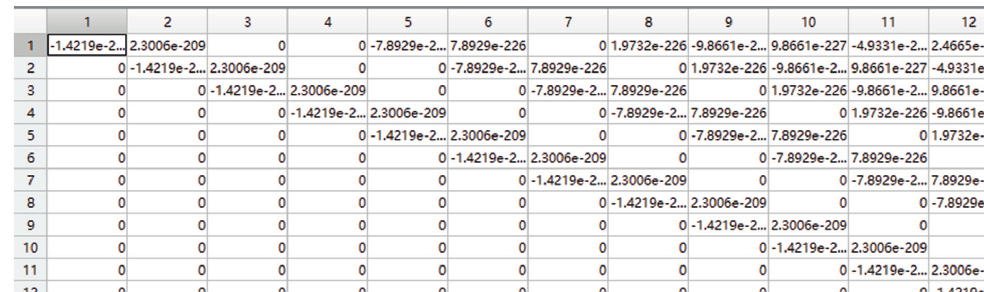
Figure 2: The result of Corollary